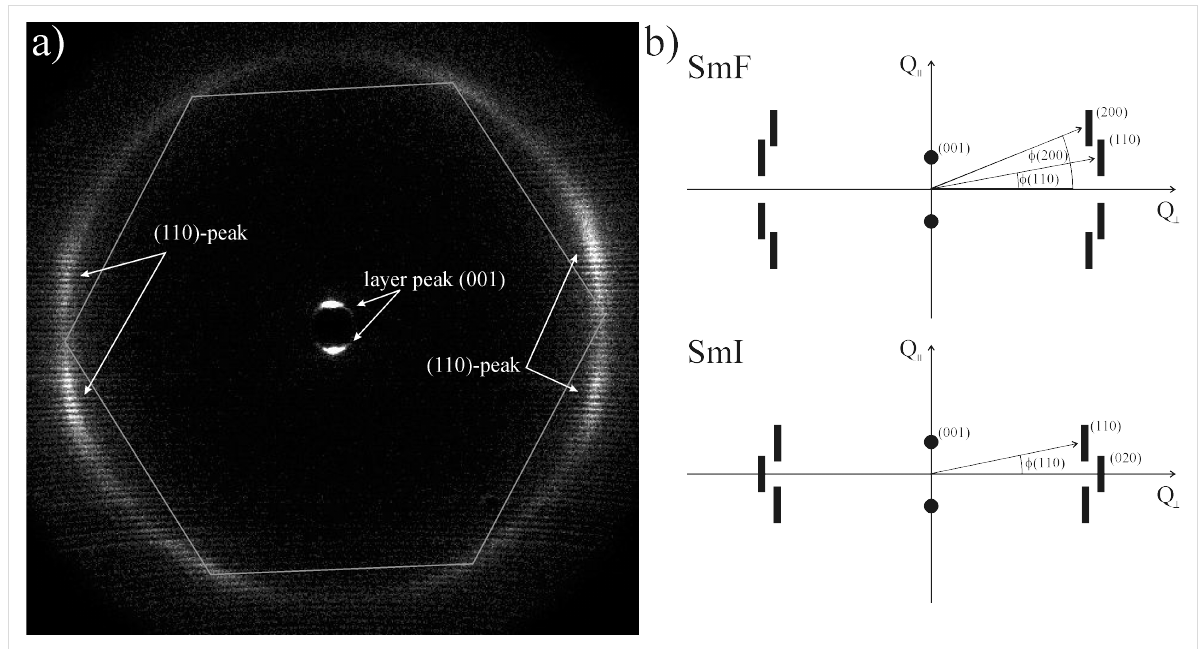
Figure 11: (a) WAXS-measurement of the SmF phase of PhP16 at T = 88 °C with the smectic layer normal oriented mostly perpendicular to the inci- dent beam. Only one wide-angle peak can be observed as well as the (001) layer peak. (b) Diffraction patterns of the SmF and SmI phase with the incident beam perpendicular to the layer normals (adapted from [14]).